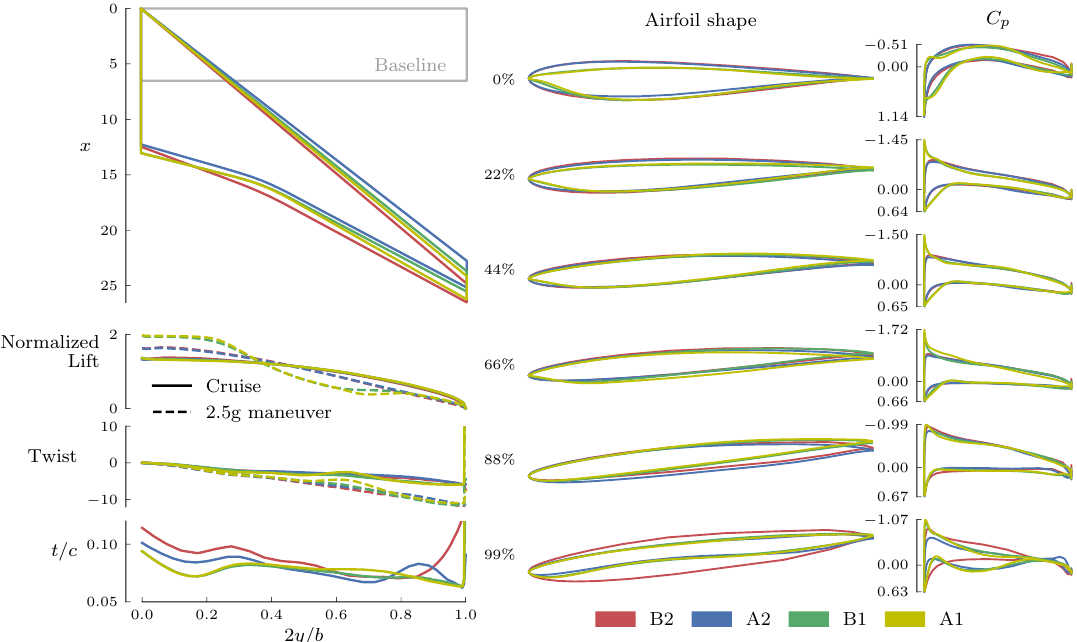
Figure 9. Each successive level of mesh refinement yields additional design